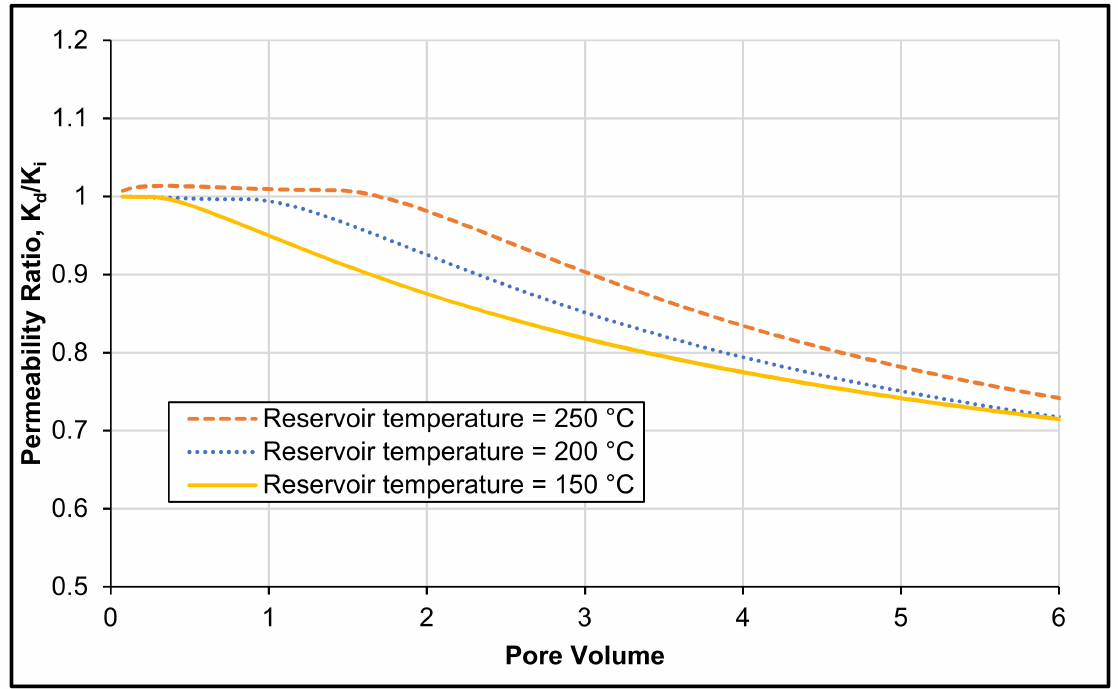
Figure 3. Formation temperature effect on permeability ratio for the first gridblock at 6 PVs with fixed water injection temperature of 100 ◦